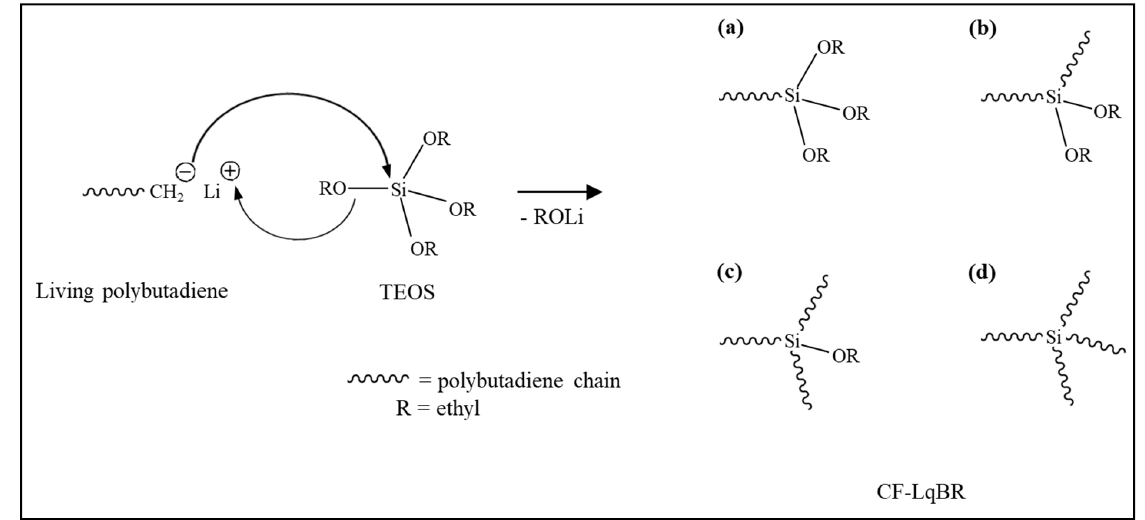
Scheme 4. Polymerization of center-functionalized liquid butadiene rubber (CF-LqBR); ( a ) BRSi(OR) 3 , ( b ) BR 2 Si(OR) 2 , ( c ) BR 3 Si(OR), and ( d ) BR 4 Table 1. Formulation for liquid butadiene rubber (LqBR) polymerization.